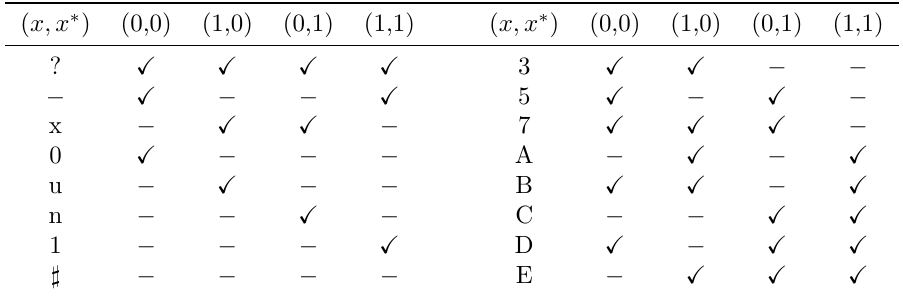
Table 2: Generalized conditions